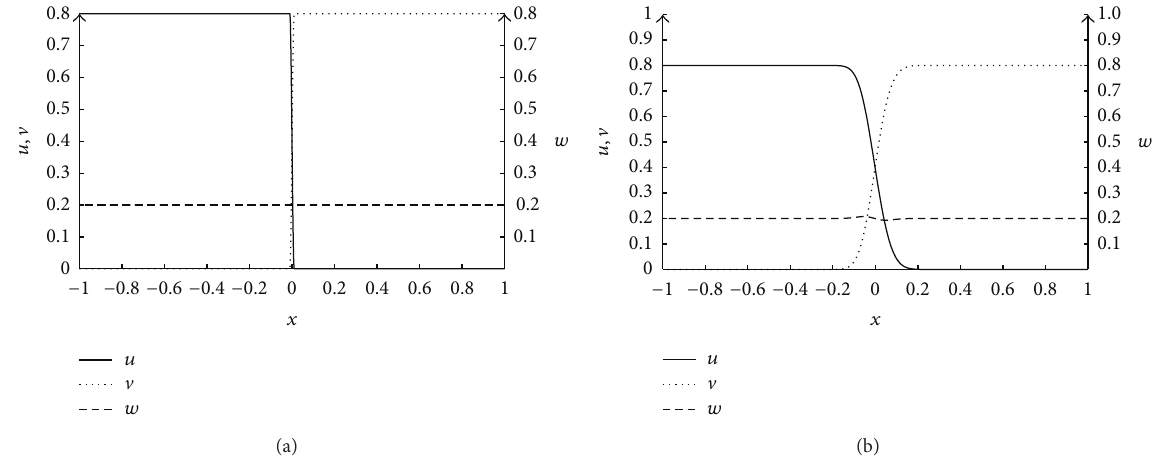
Figure 3: Experimental values of 𝑢 , V , and 𝑤 for 𝑡 = 0.01 , ℎ = .002 .